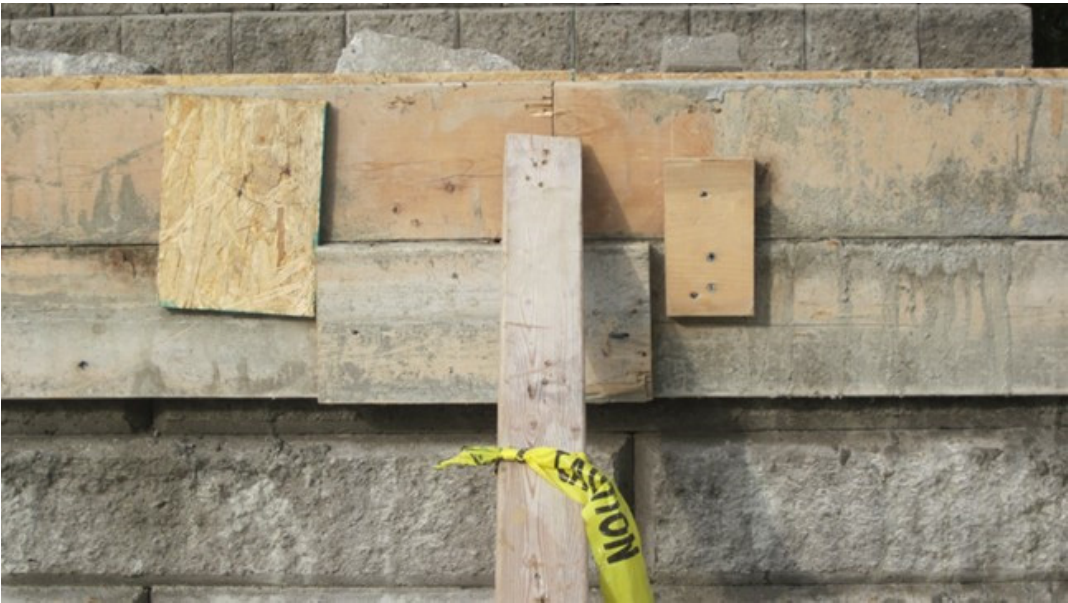
Figure 3. Lateral bracing of formwork for concrete cap on top of a block retaining wall.